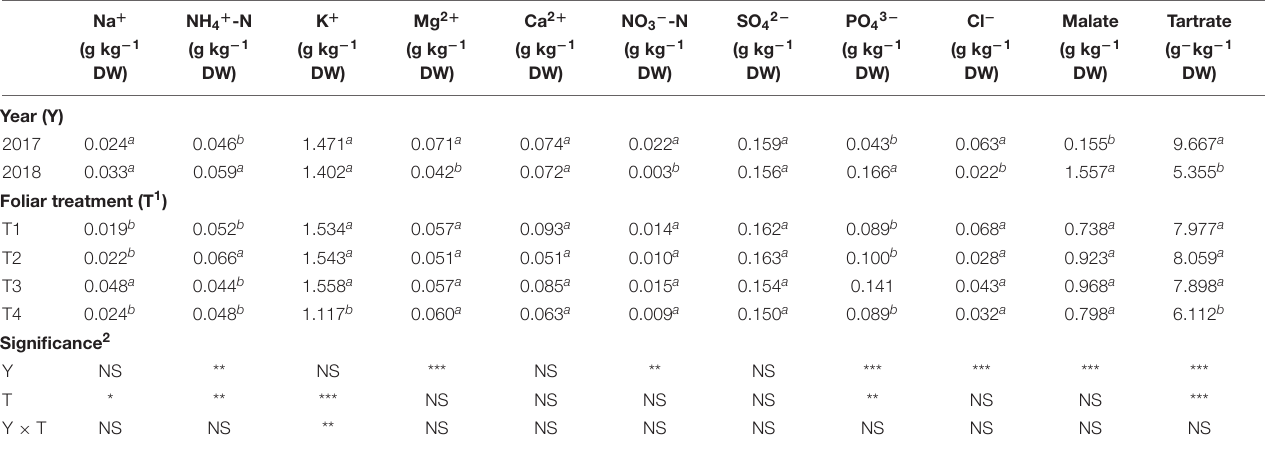
TABLE 6 | Main effects of year and foliar treatments on fruit mineral composition of V. vinifera “Aglianico” vines. Mean values and significance of interactions are shown. Different letters within column indicate significant differences according to Duncan’s multiple-range test ( P ≤